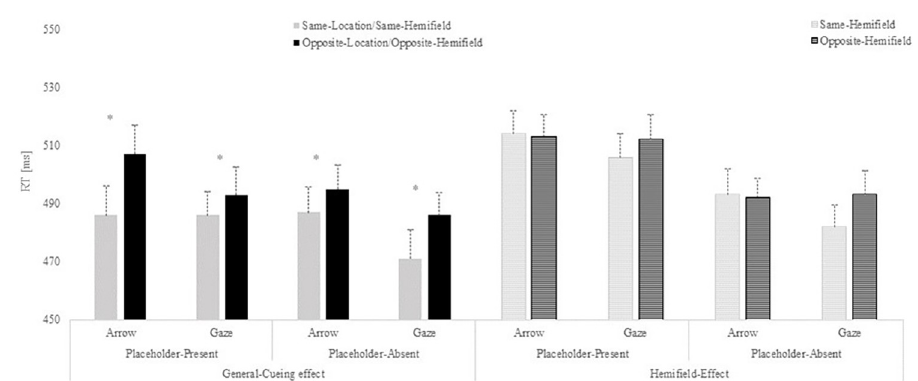
Fig 3. Reaction times (RTs) results from Experiment 1. Results are shown separately for the general-cueing effect (Same-Location/Same Hemifield vs. Opposite-Location/Opposite Hemifield) and the hemifield-effect (Same- Hemifield vs. Opposite Hemifield). Mean RTs presented for each type of cue as a function of the cue-target relation in the placeholder-present and placeholder-absent conditions. Error bars represent the standard error of the mean, computed following Cousineau’s [31] method to eliminate variability between